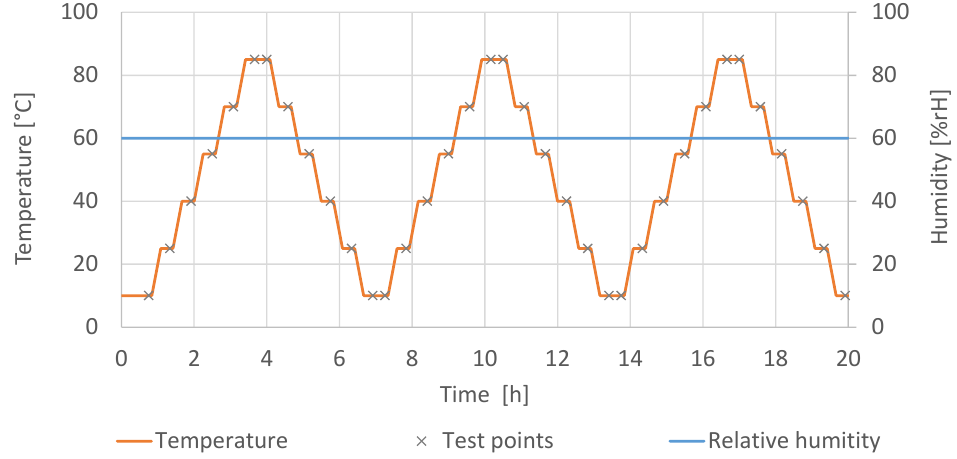
Figure 4. Course of temperature and relative humidity of the climate chamber. The cycles were selected according to IEC 61928-2.